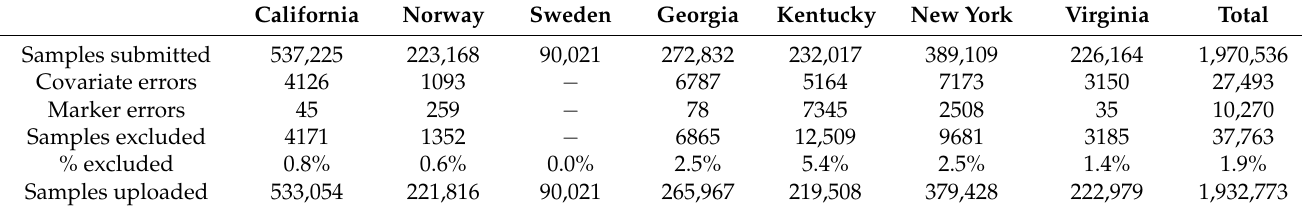
Table 2. Summary of reference data at the time of submission and after exclusion